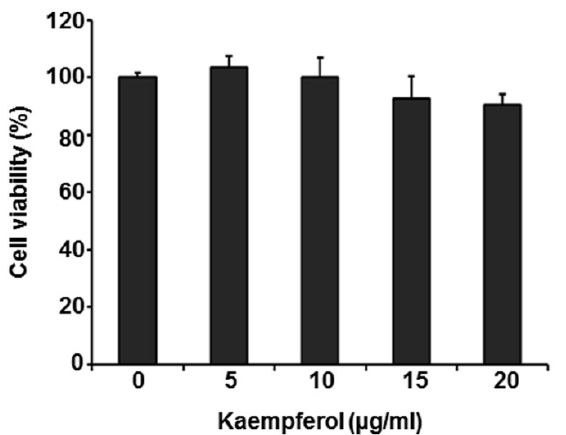
Figure 2. Cytotoxicity of kaempferol. HFFs were treated with kaempferol at the indicated concen- trations. At 72 h after treatment, cell viability was determined by MTT assay and expressed rela- tive to that of cells treated with DMSO (defined as 100%).